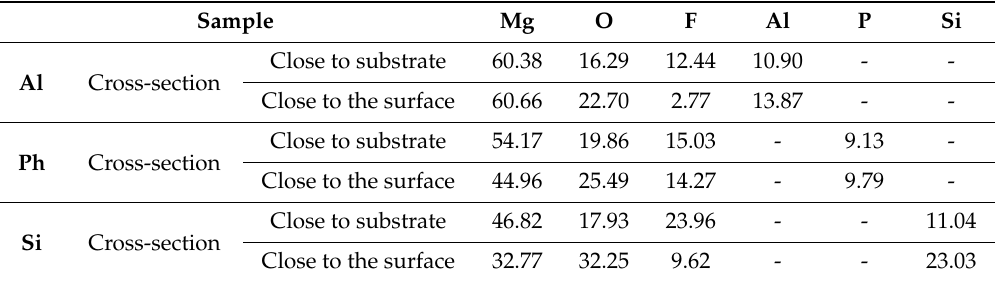
Table 3. The elemental composition of PEO coating produced at di ff erent electrolytes